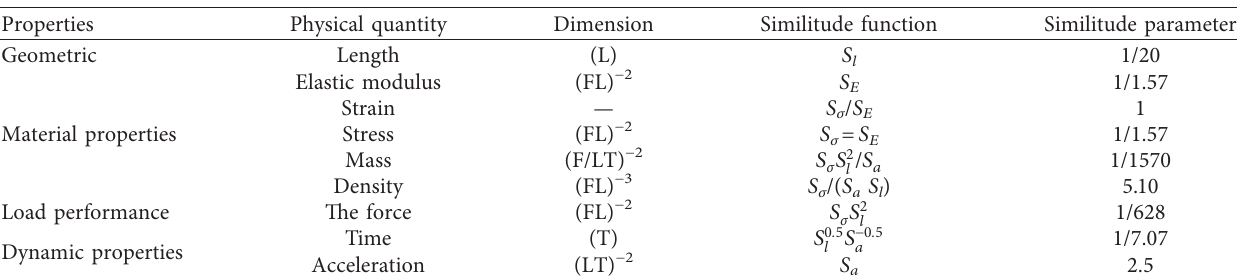
Figure 1: The expansion device. (a) The physical diagram of expansion device. (b) The design diagram of expansion device. Table 1: Similar constants.